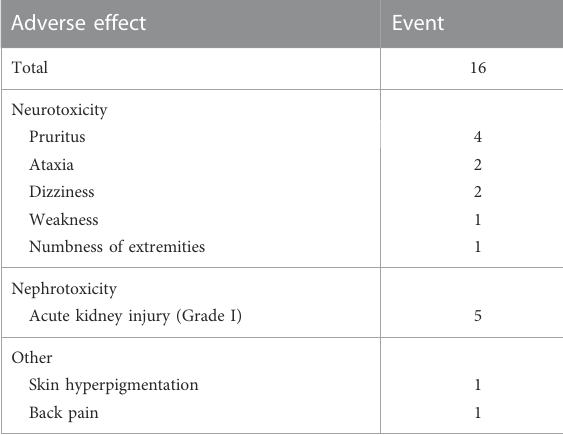
TABLE 3 Adverse events following intravenous administration of polymyxin B in patients with CRKP bloodstream infections. Adverse